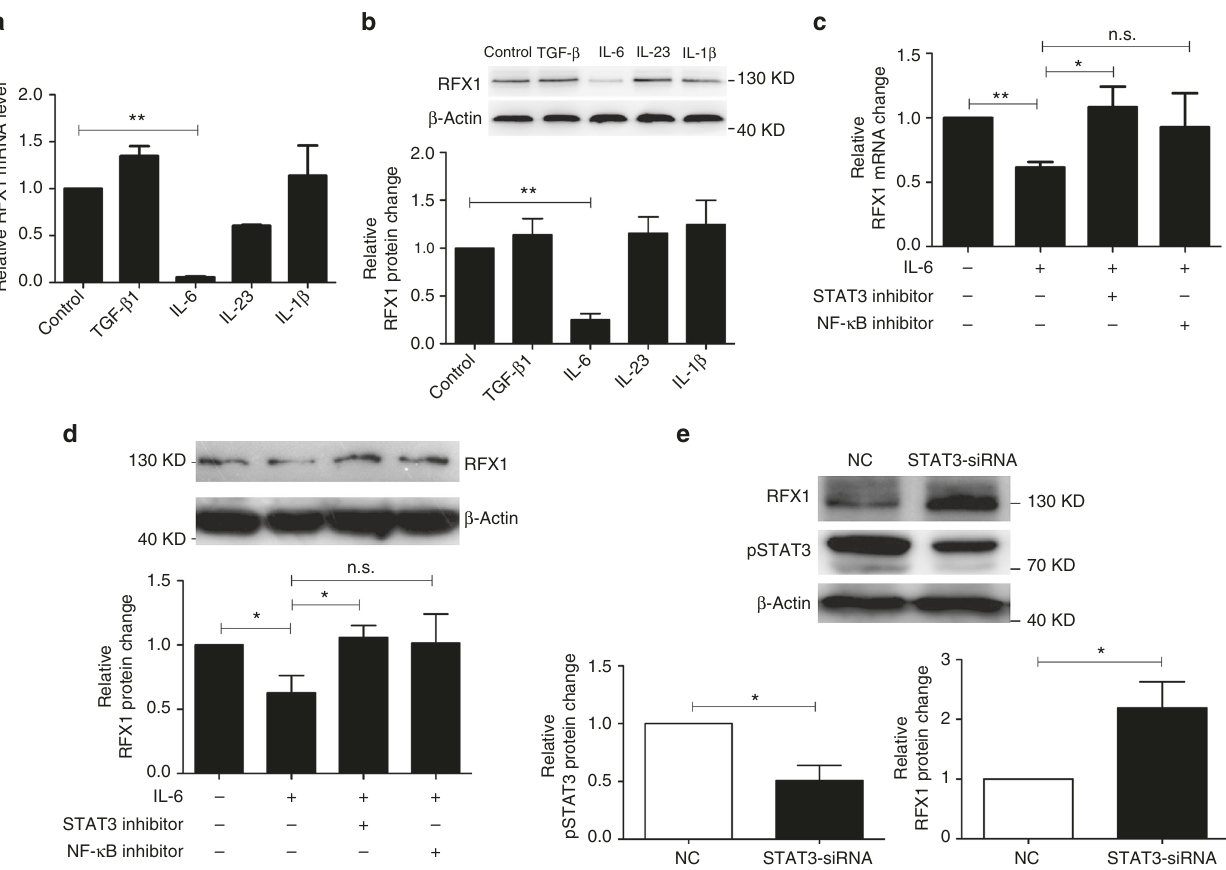
Fig. 8 The IL-6-STAT3 pathway inhibits RFX1 expression. a , b qPCR and western blot analysis of RFX1 mRNA and protein expression levels in CD4 + T cells upon TGF- β , IL-6, IL-23, or IL-1 β stimulation. c , d qPCR and western blot analysis of RFX1 mRNA and protein expression levels in CD4 + T cells stimulated by IL-6 along with STAT3 inhibitor or NF- κ B inhibitor. The y axis indicates the fold-change in RFX1 expression compared with a negative control. e Western blot analysis of RFX1 and phosphorylated STAT3 (pSTAT3) in CD4 + T cells transfected with STAT3 siRNA or negative control (NC) at 48 h after transfection. Negative control was set as “ 1 ” . The y axis indicates the fold-change in RFX1 expression compared with a negative control. The protein expression level is calculated by the ratio of protein to β -actin. Data are representative of three independent experiments (mean ± s.d.; n = 3). * P < 0.05, ** P < 0.01, compared between the indicated groups. n.s., not signi fi cant. P -values were determined using two-tailed Student ’ s t